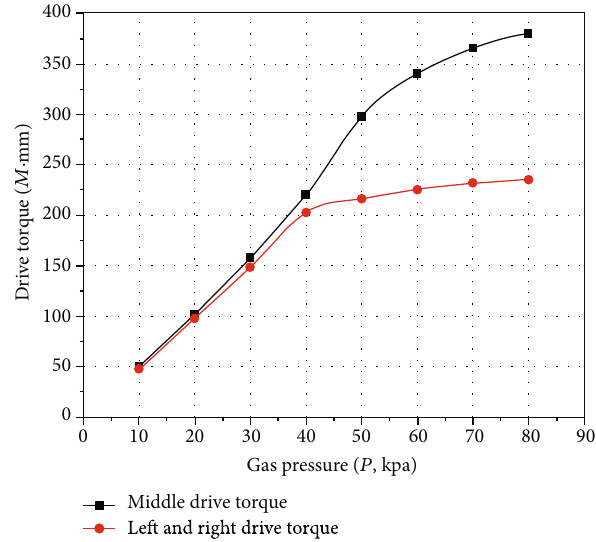
Figure 17: P ‐ M characteristic curves of pneumatic soft-bodied bionic actuator for variable angle. Table 5: Empirical formula coe ffi cients of P − M characteristic curves.